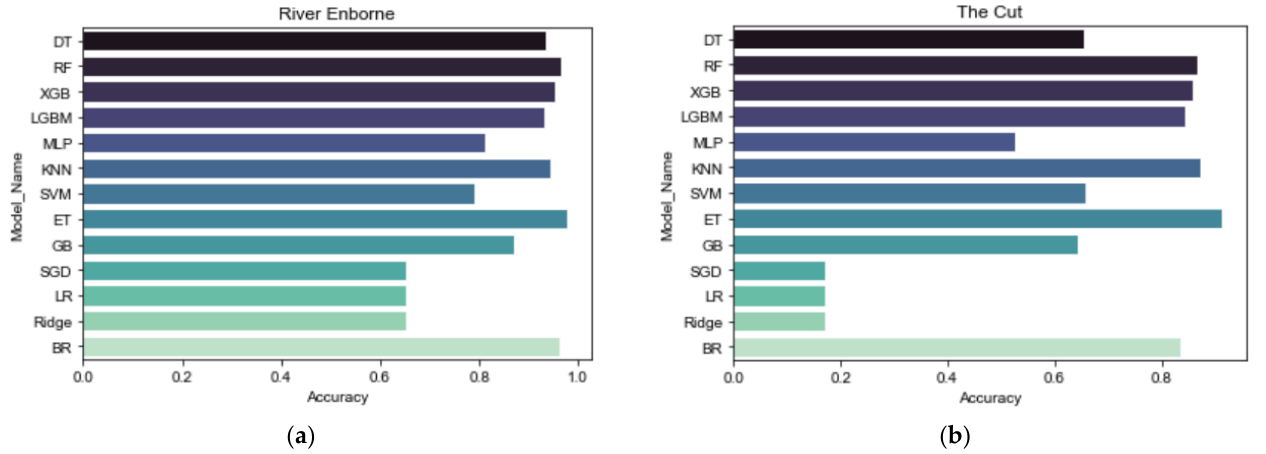
Figure 3. ( a ) Spot checking nitrate predictive performance in the River Enborne; ( b ) Spot checking nitrate predictive performance in The Cut. Table 4. Performance comparison of RF and ET models using RMSE ± standard deviation (std). Predictors in RF and ET